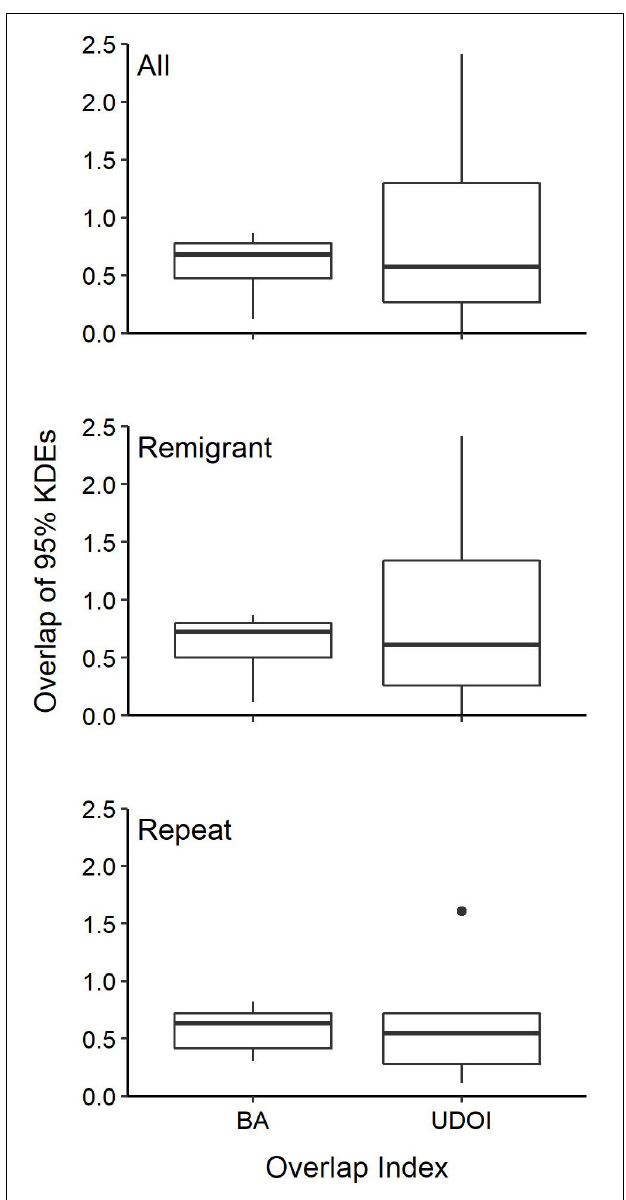
FIGURE 7 | Kernel-density estimates (KDEs) of foraging area overlap for individual post-nesting female Kemp’s ridley sea turtles with transmitters deployed between 2010 and 2017. Individuals were tracked multiple times (Repeat) or tracked remigrating back to the nesting beach and then returning to the foraging grounds during their deployment (Remigrant). Remigrant and Repeat tracks were also combined (All) to show overall intra-individual overlap of foraging areas. BA, Bhattacharyya’s affinity; UDOI, utilization distribution overlap index. Boxes bound the 25th and 75th percentiles, the solid line indicates the median, dots represent outliers, and the whiskers extend 1.5 times the interquartile range.